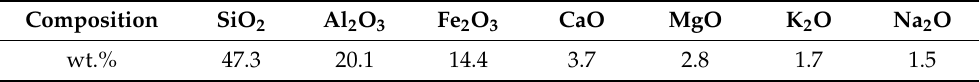
Figure 2. XRD spectrum of drill cutting. Table 1. Chemical composition of drill cutting (Chu-Huang-Keng drilling site, Miao-Li County).